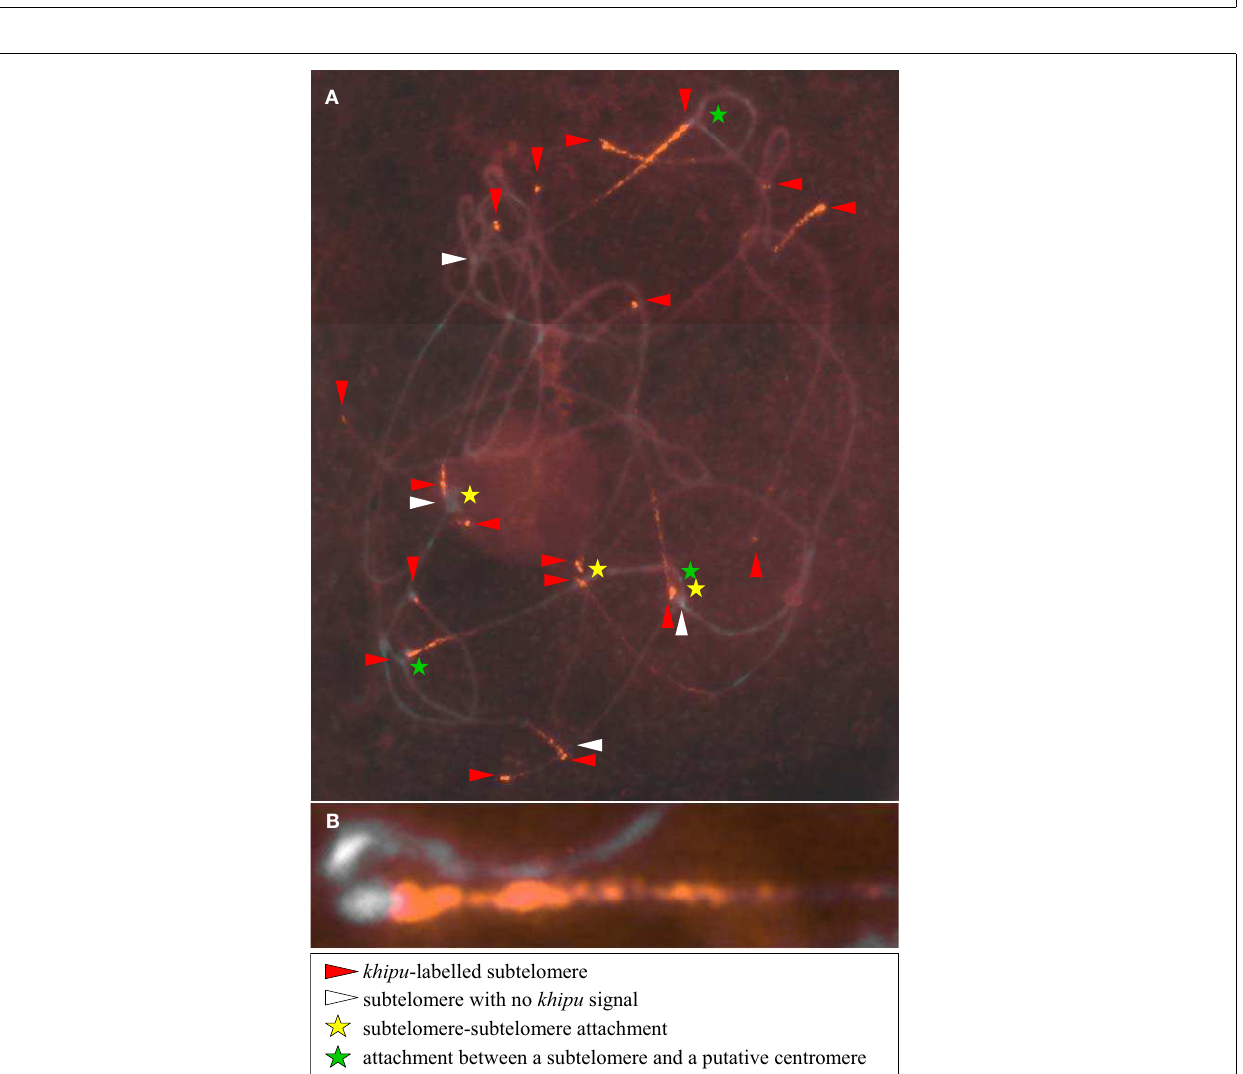
FIGUREA3 | Physical distribution of khipu on G19833 pachytene chromosomes using FISH . FISH to G19833 pachytene chromosomes. Khipu was used as a probe in (B) and (C) . Signals